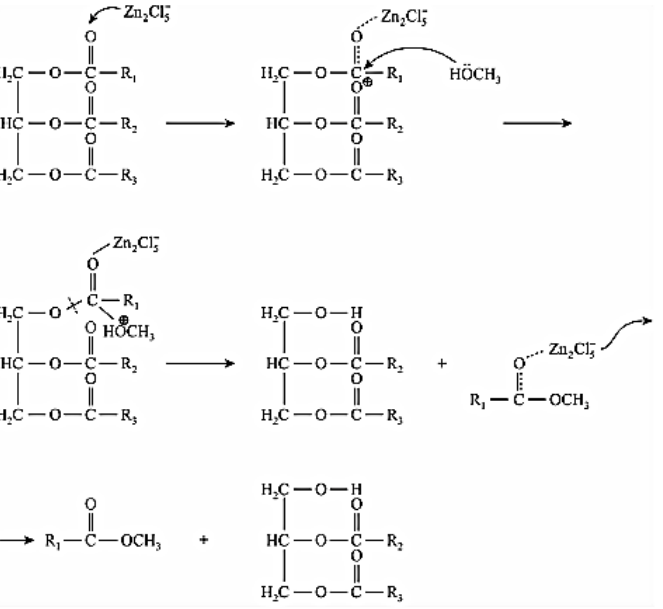
Figure 2. The proposed transesterification mechanism. Reprinted from reference [67] with permis-